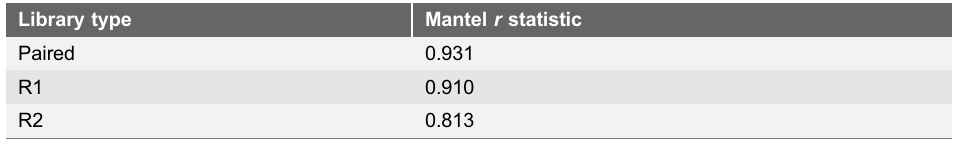
Table 2. Library comparison in a realistic